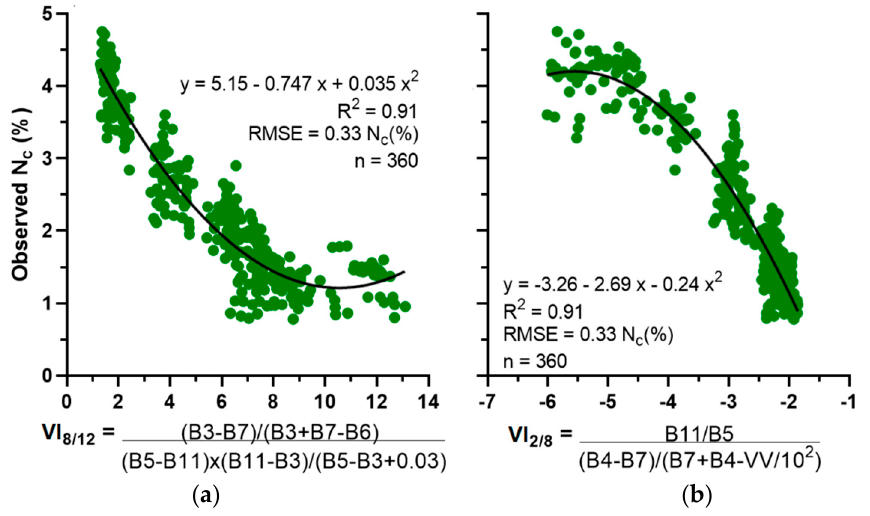
Figure 5. Plant nitrogen concentration (Nc) in corn modeled with vegetation indices (VI) selected from ( a ) the combination of spectral bands and ( b ) sensor data fusion for the whole crop cycle. VI suffixes refer to the formula used according to Table 3 (e.g., VI 8/12 is VI 8 divided by VI 12 ). The spectral bands from Sentinel-2 were B3 (green, 559 nm), B4 (red, 665 nm), B5 (red-edge 1, 704 nm), B6 (red-edge 2, 740 nm), B7 (red-edge 3, 780 nm), and B11 (short-wave infrared spectral range 1, 1375 nm); C-SAR backscatter from Sentinel-1 was VV in decibels with absolute values. A and B are significant models ( p -value < 0.001). RMSE: root-mean-square error.